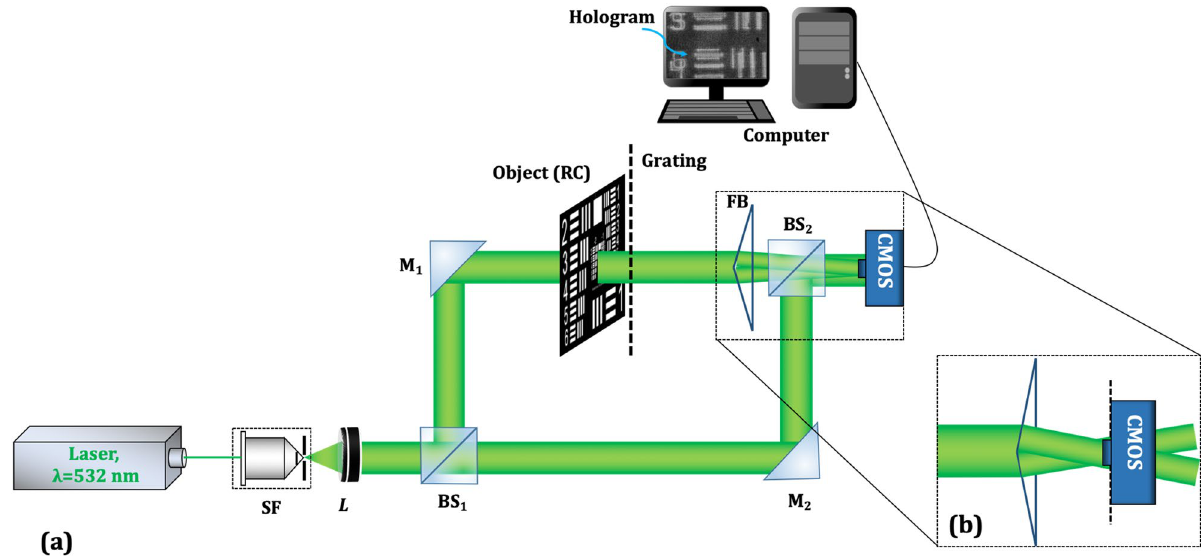
Figure 2. ( a ) Schematic of the experimental setup and ( b ) enlarged view of two FOV generations by FB (excluding the reference beam and BS 2 ).